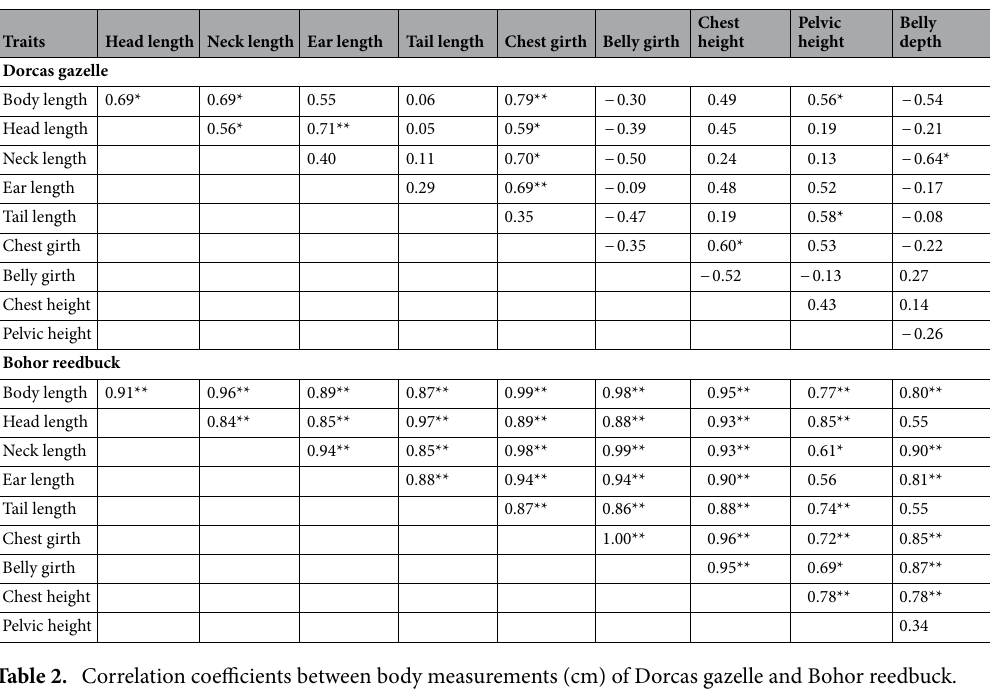
Table 2. Correlation coefficients between body measurements (cm) of Dorcas gazelle and Bohor reedbuck. *Significant at P < 0.05. **Significant at P < 0.01.